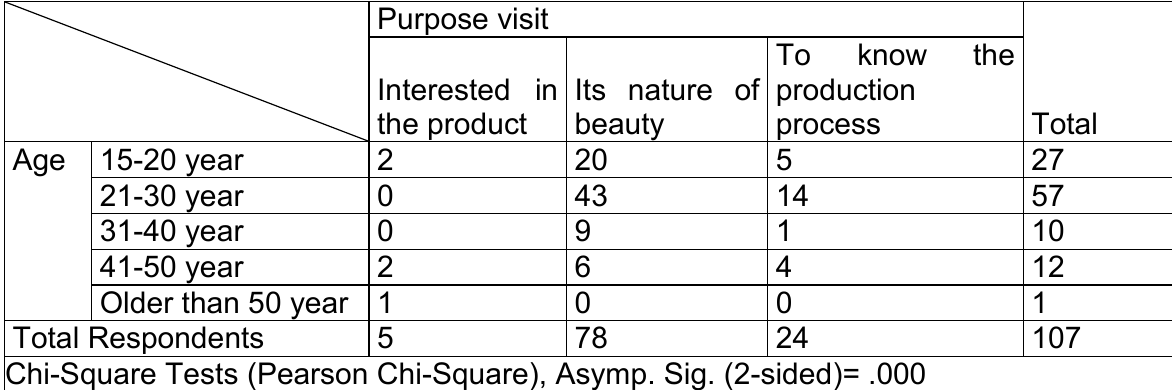
Table 2 The Correlation between Age Group and the Purpose of Visit to JTA Purpose